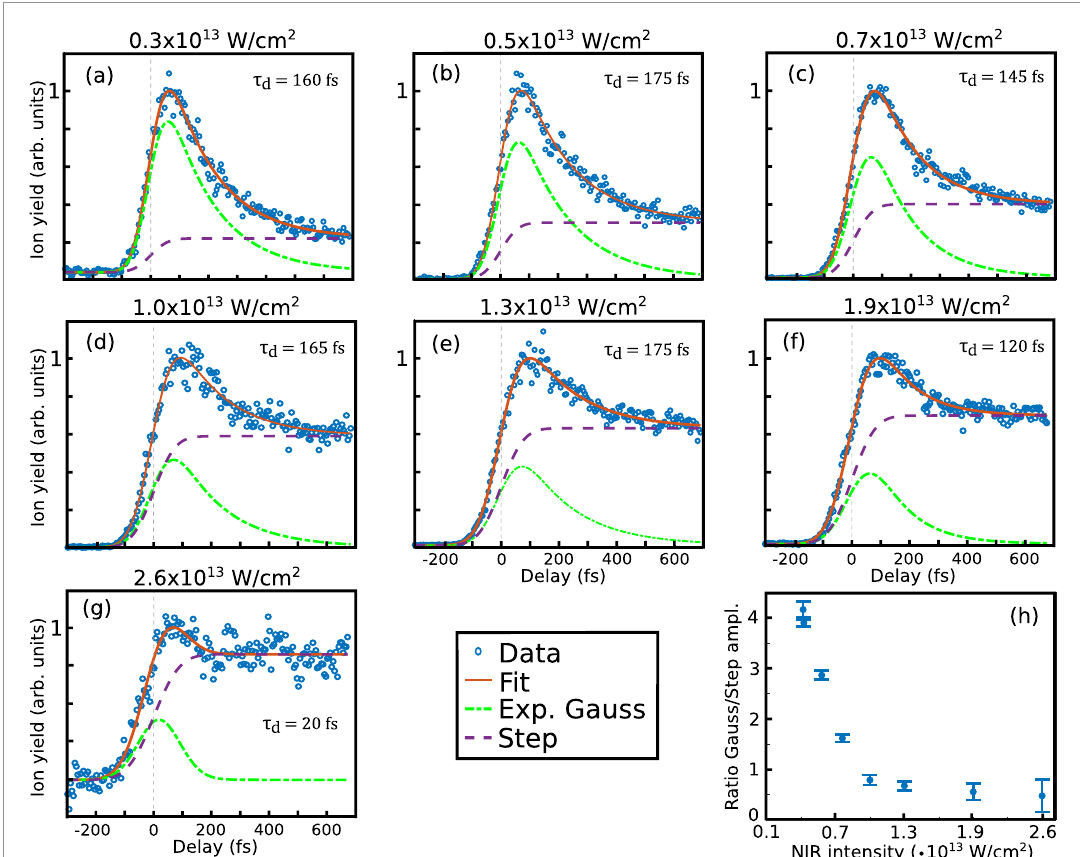
Figure 5. Kr 2 + ion yields as a function of XUV-pump and NIR-probe delay, obtained with HH19 at different NIR intensities (0.3–2 . 6 × 10 13 Wcm − 2 ) (a)–(g). Measured ion yields (blue circles) are fitted with a step (purple dashed line) and a Gaussian function convoluted with an exponential decay (green dashed line). The combined fits to the ion yields are plotted as red solid curves. (h) Shows the ratio between the Gaussian and smoothed step functions maximum amplitudes versus of the NIR intensity. Error bars show the 95 % confidence bound obtained from the